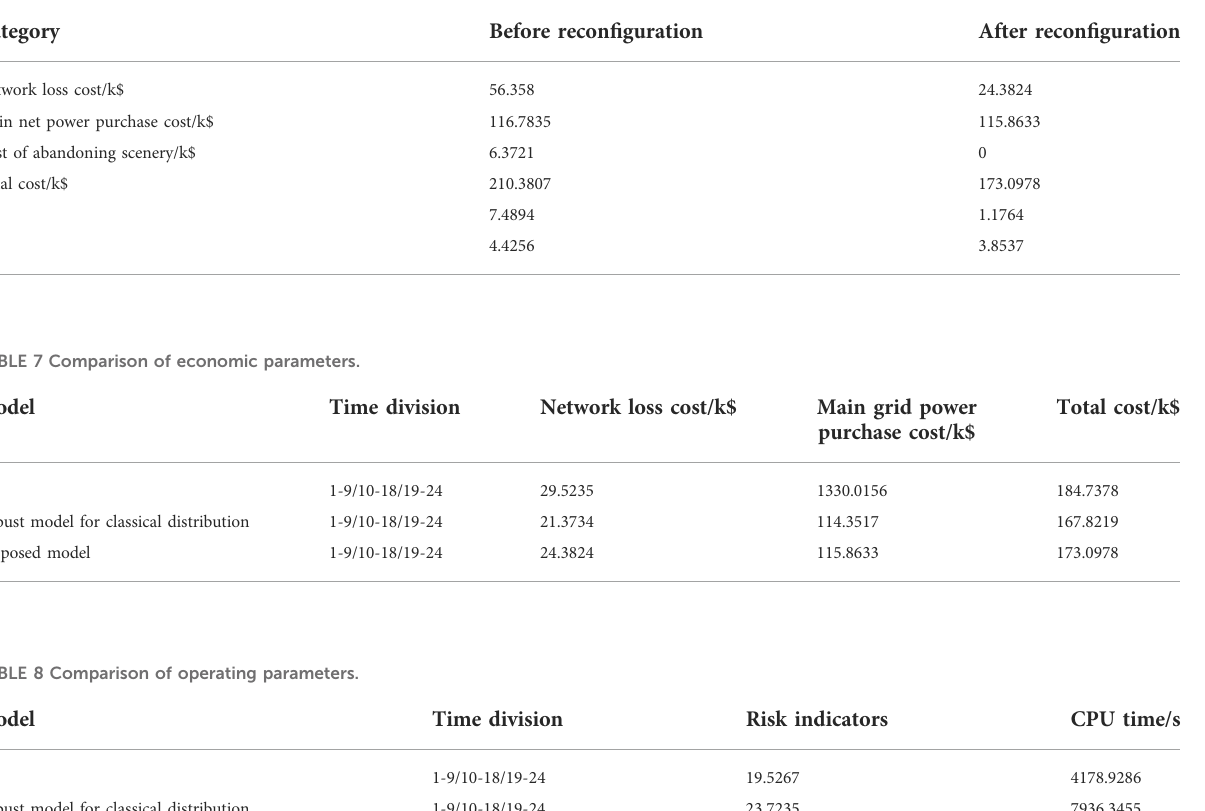
TABLE 6 Impacts of recon fi guration.